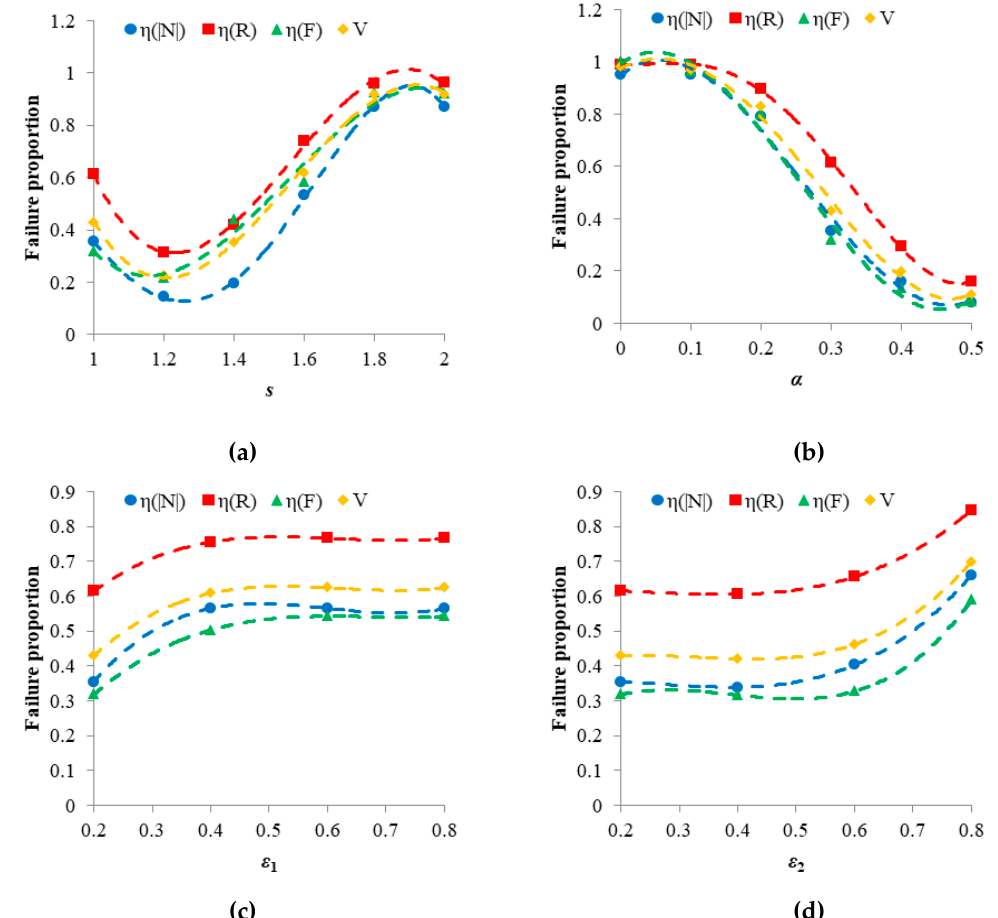
ε , and Figure 12. The change of η (| N |), η ( R ), η ( F ) and V changes with s , α , ε 1 , and ε 2 . ( a ) α = 0.3, ε 1 = ε 2 = 0.2; 1